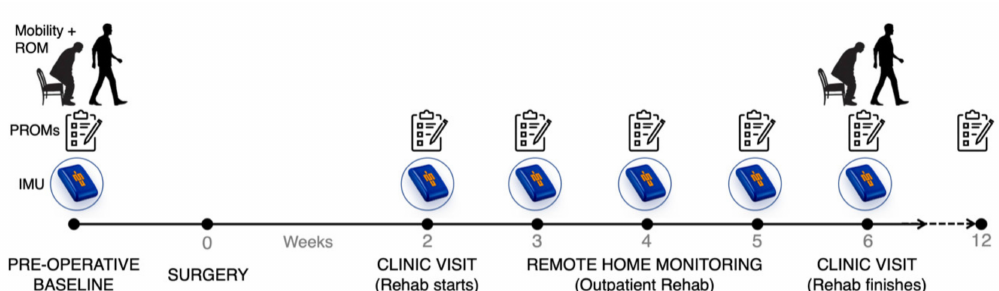
Figure 1. Schematic representing our workflow for post-operative remote patient monitoring of patients following total knee arthroplasty using inertial measurement units (IMUs). Mobility and knee flexion range of motion (ROM) were taken at baseline and 6 weeks post-op. Patient-reported outcome measures (PROMs) were taken at each time point as well as at 12-weeks